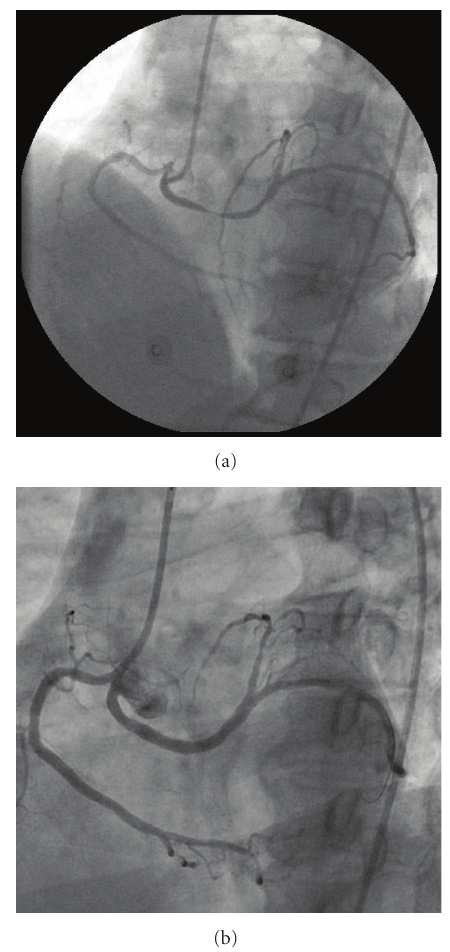
Figure 2: Coronary angiogram. (a) Anomalous LMCA with sig- nificant stenosis and its course. (b) Shows well-deployed stent in